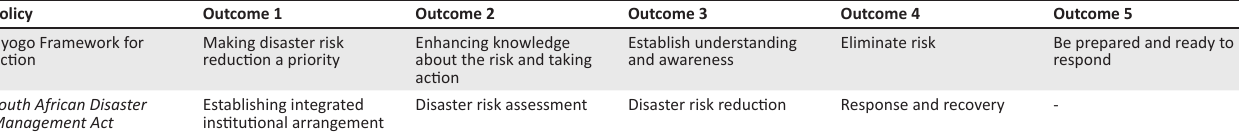
TABLE 1: Policy outcomes Hyogo Framework for Action and South African Disaster Management Act